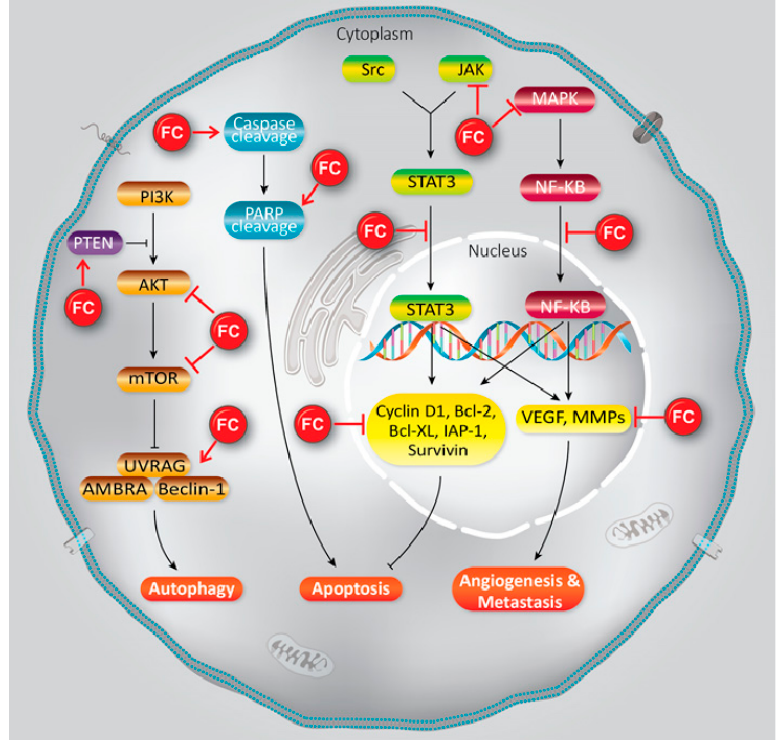
Figure 1. A schema of different molecular mechanisms that are targeted by furanocoumarin. It shows several molecular singling pathways modulation that leads to autophagy, apoptosis, angiogenesis, and metastasis. Black lines: induce, and red lines: inhibit.